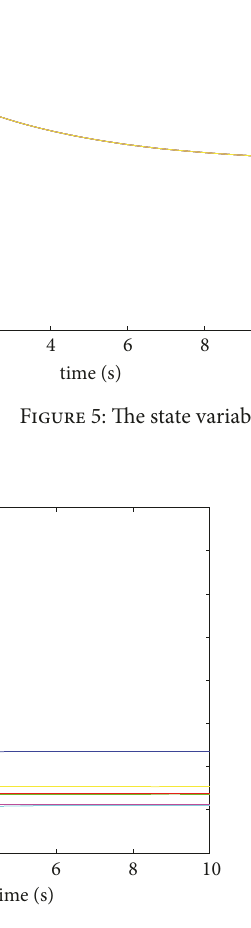
Figure 6: The adaptive law under the node-based algorithm.